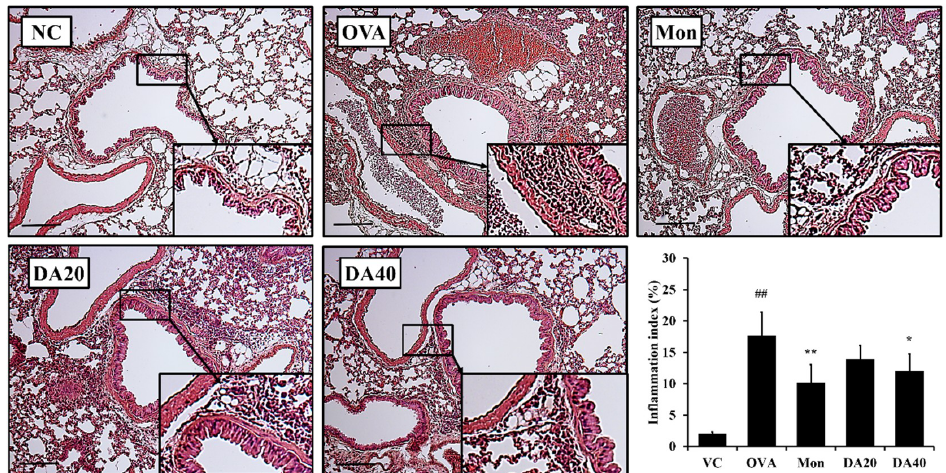
Figure 4. DA suppressed inflammatory cell infiltration in the lung tissue of OVA-induced asthma model. The DA-treated mice exhibited lower inflammatory cell infiltration into the lung tissue than OVA-induced asthma model. NC: normal controls, PBS treatment and inhalation; OVA: PBS treatment with OVA sensitization and inhalation; Mon: montelukast-treated mice (10 mg/kg, oral gavage) with OVA sensitization and inhalation; DA20 and 40: Dipsacus asperoides C. Y. Cheng et T. M. Ai-treated mice (20 and 40 mg/kg, respectively, oral gavage) with OVA sensitization and inhalation. Scale bar = 50 µm. The values shown are the mean ± SD. ## p < 0.01 vs. NC; * p < 0.05, ** p < 0.01, respectively.